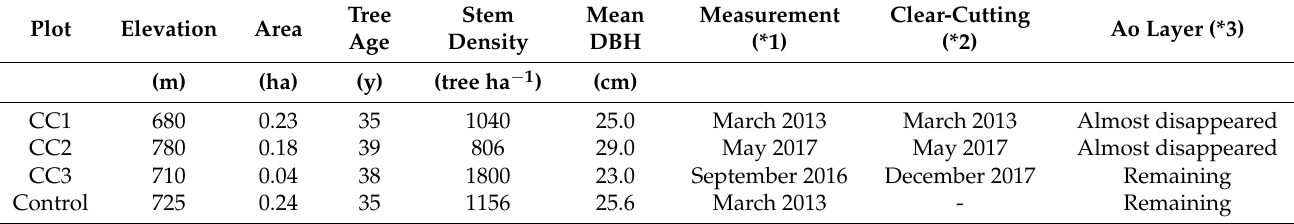
Table A1. Basic information on the clear-cutting plots (CC1, CC2, and CC3) and the